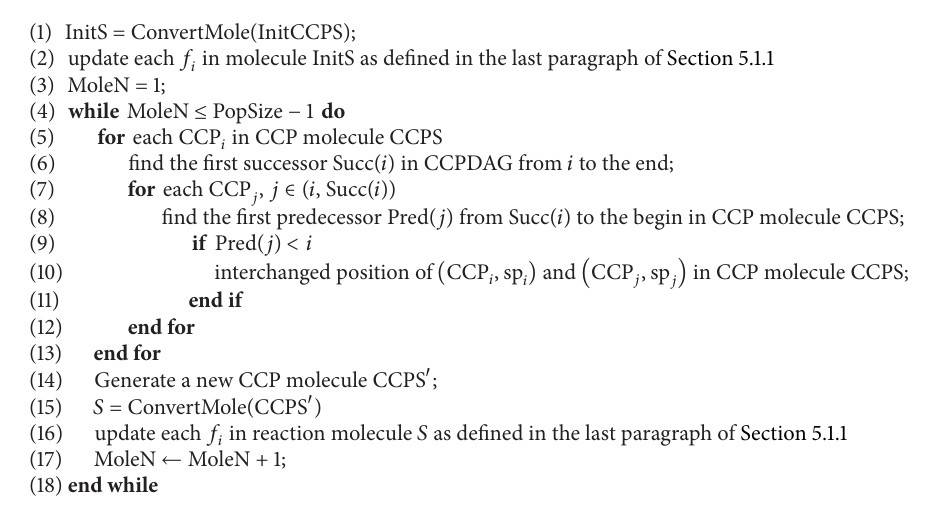
Algorithm 3: InitTMolecule(InitCCPS) generating the initial population.